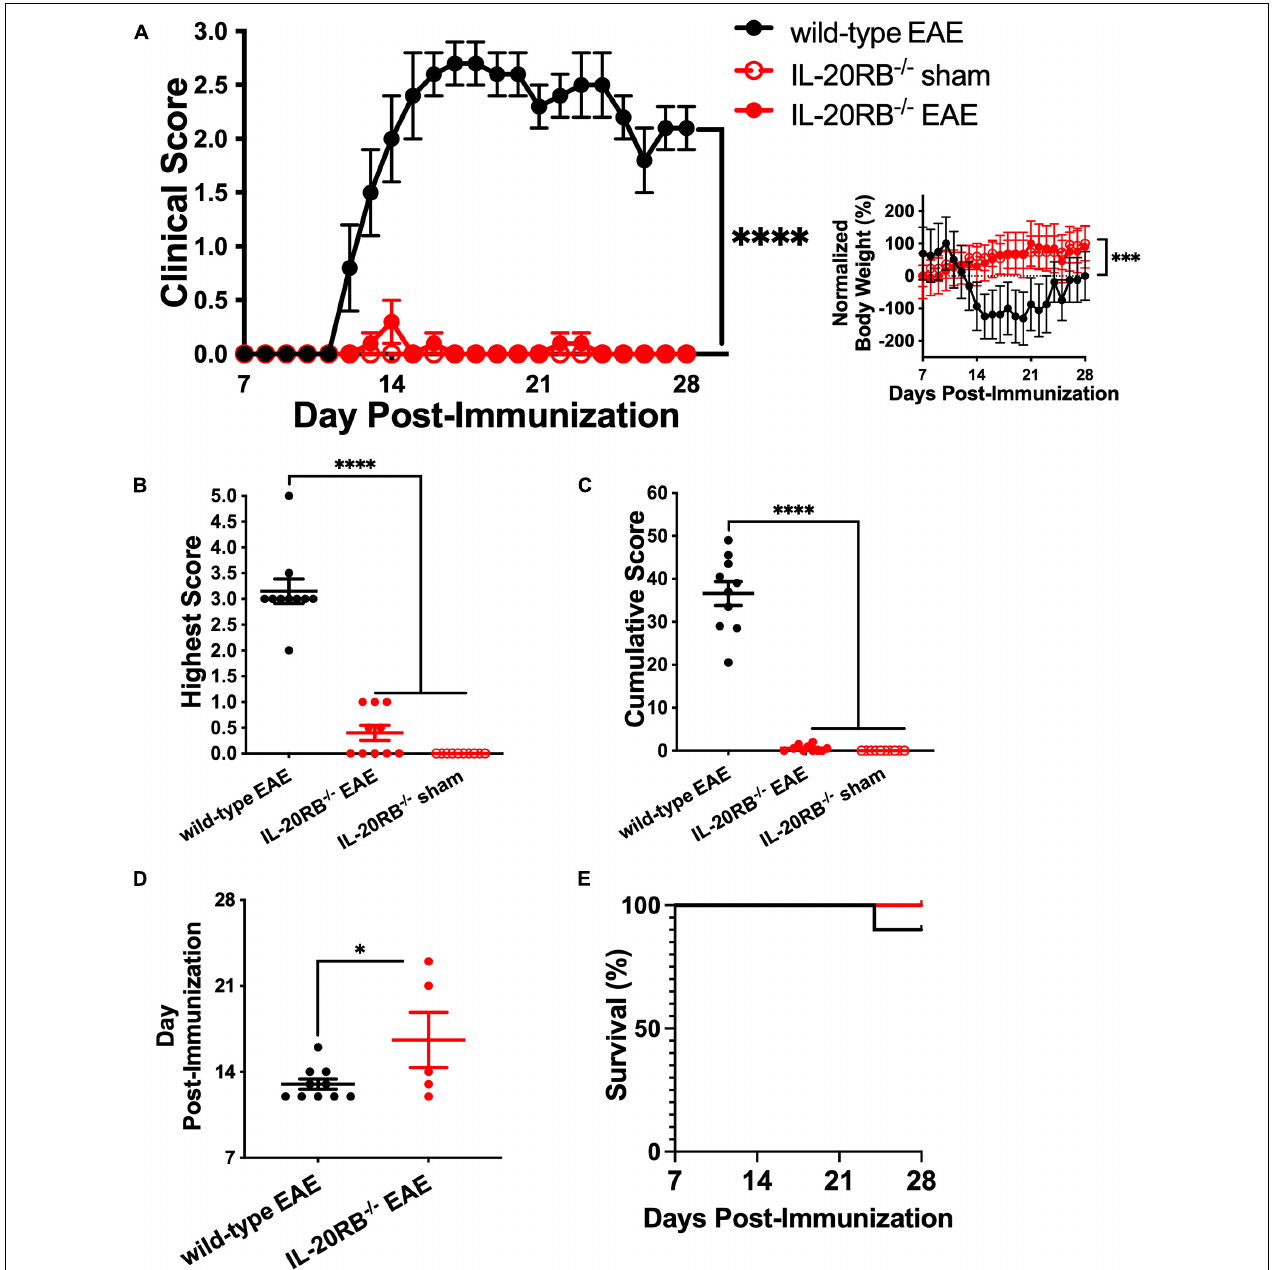
FIGURE 1 | Genetic ablation of IL-20RB ameliorates EAE. Ten week-old IL-20RB − / − mice and wild-type mice, male and female, were actively immunized for EAE (red circle and black circle, respectively), using IL-20RB − / − sham-immunized mice (red outline) as control ( n = 10). Clinical score, normalized body weight, highest and cumulative scores from 7 to 28 dpi were analyzed by non-parametric Kruskal–Wallis followed by Dunn’s post hoc test comparing actively immunized IL-20RB − / − mice with wild-type mice, and actively immunized IL-20RB − / − mice with sham-immunized IL-20RB − / − mice (A–C) . Difference in clinical score between IL-20RB − / − mice with EAE (mean ± SEM: 0.03 ± 0.02) and wild-type mice (mean ± SEM: 1.72 ± 0.22) with EAE showed extreme statistical significance, p < 0.0001, while no difference was observed when compared with sham-immunized IL-20RB − / − mice (mean ± SEM: 0.00 ± 0.00) (A) . Likewise, difference in normalized body weight was highly significant between IL-20RB − / − mice with EAE (mean ± SEM: 51.82 ± 6.81) and wild-type mice (mean ± SEM: –39.77 ± 16.21) with EAE p < 0.001 but not when compared to sham-immunized IL-20RB − / − mice (mean ± SEM: 59.24 ± 5.40) ( A , insert). Highest (B) and cumulative scores (C) analysis showed extreme statistical significance for IL-20RB − / − mice with EAE (mean ± SEM highest score: 0.40 ± 0.15, cumulative score: 0.55 ± 0.23) and wild-type mice with EAE (mean ± SEM highest score: 3.15 ± 0.24, cumulative score: 36.60 ± 2.78), p < 0.0001, but not with sham-immunized IL-20RB − / − mice (mean ± SEM highest score: 0.00 ± 0.00, cumulative score: 0.00 ± 0.00). Analysis of EAE disease onset by unpaired t -test for actively immunized IL-20RB − / − mice with neurologic symptoms (5/10, mean ± SEM: 16.60 ± 2.25) and wild-type mice (mean ± SEM: 13.00 ± 0.42) showed statistical significance, p < 0.05 (D) . Analysis of percentage of survival was not deemed significant (E) . Results are shown as mean ± SEM, ∗ p < 0.05, ∗∗∗ p < 0.001, and ∗∗∗∗ p <